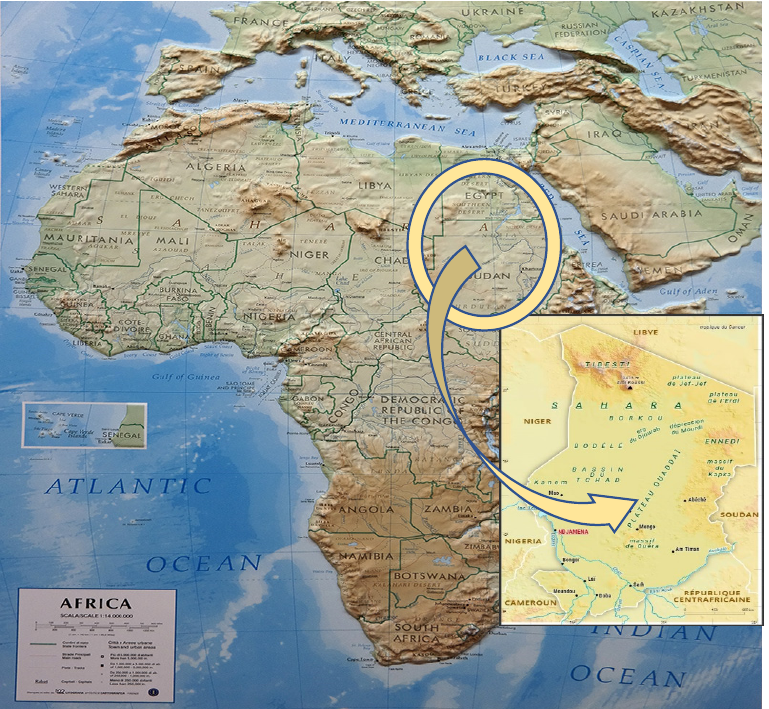
Figure 18. Map of African landforms from: https://sanfordbernice.blogspot.com/2020/07/afrique- carte-relief.html accessed on 1 January 2022.